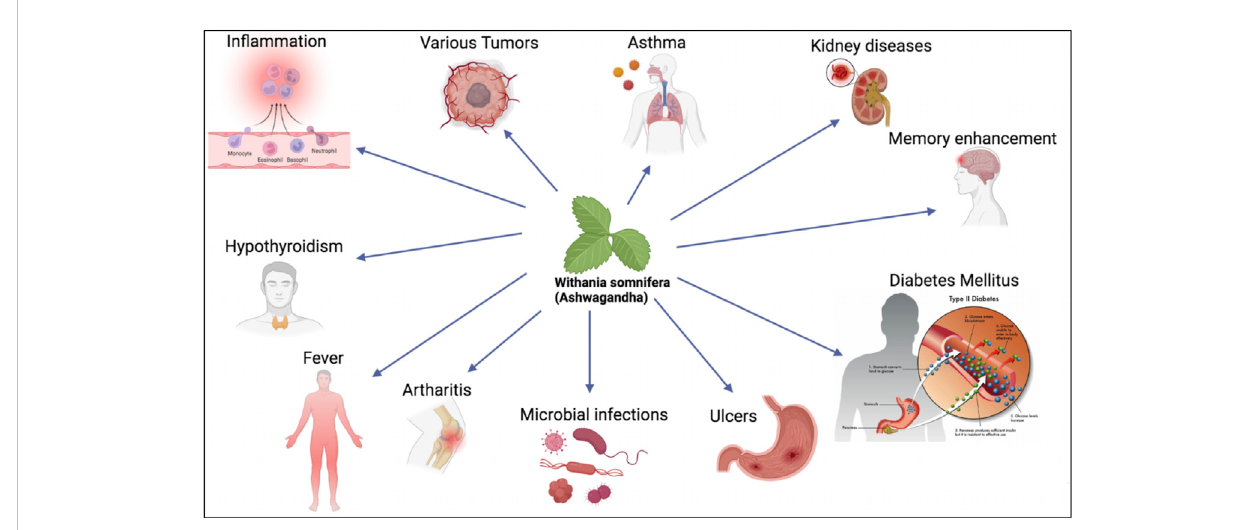
FIGURE 1 W. somnifera is used as botanical drug to treat various chronic diseases including asthma, kidney diseases, diabetes mellitus and